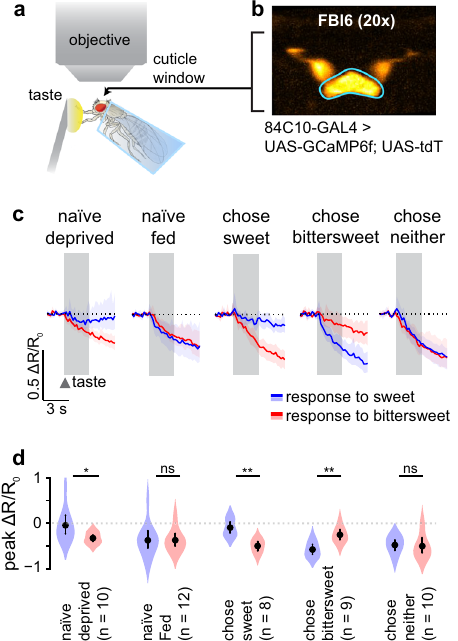
Fig. 4 Neural activity in FBl6 encodes food choice. a In vivo Ca 2 + imaging of taste responses in FBl6 neurons of fl ies in different hunger states making different sweet-bittersweet decisions. Sweet or bittersweet taste stimuli are applied to the forelegs, and changes in Ca 2 + responses are measured ratiometrically in FBl6 using GCaMP6f and tdTomato. b Neuronal expression in FBl6 reported by tdTomato. Region of interest for fl uorescence measurement is outlined in cyan. 84C10-GAL4 driver line is used to speci fi cally target strong fl uorescent protein expression in FBl6 neurons 106,107 (Supplementary Fig. 3b – d). c Ratiometric calcium responses, Δ R/R fl ies with different hunger state and decision outcomes. Sweet 0 , of (50 mM sucrose) and bittersweet (500 mM sucrose + 1 mM quinine) taste stimuli from the equal-preference condition were applied for 3 s, and neural response was quanti fi ed for 4 s post-stimulus application. Taste stimulus application is indicated by gray background region. FBl6 neurons were strongly inhibited by the behaviorally rejected taste stimulus. Speci fi cally, FBl6 neurons of fl ies that chose sweet were inhibited by bittersweet taste, while FBl6 neurons of fl ies that chose bittersweet were inhibited by sweet taste. c Calcium activity trace depicts mean Δ R/R 0 ± 95% CI. d Peak Δ R/R 0 shows signi fi cant difference between responses to rejected vs. chosen taste within each fl y condition. p < 0.05 = * (see Supplementary Table 1 for details on statistics). Points on graphs depict mean ± 95% CI, with violins depicting full data